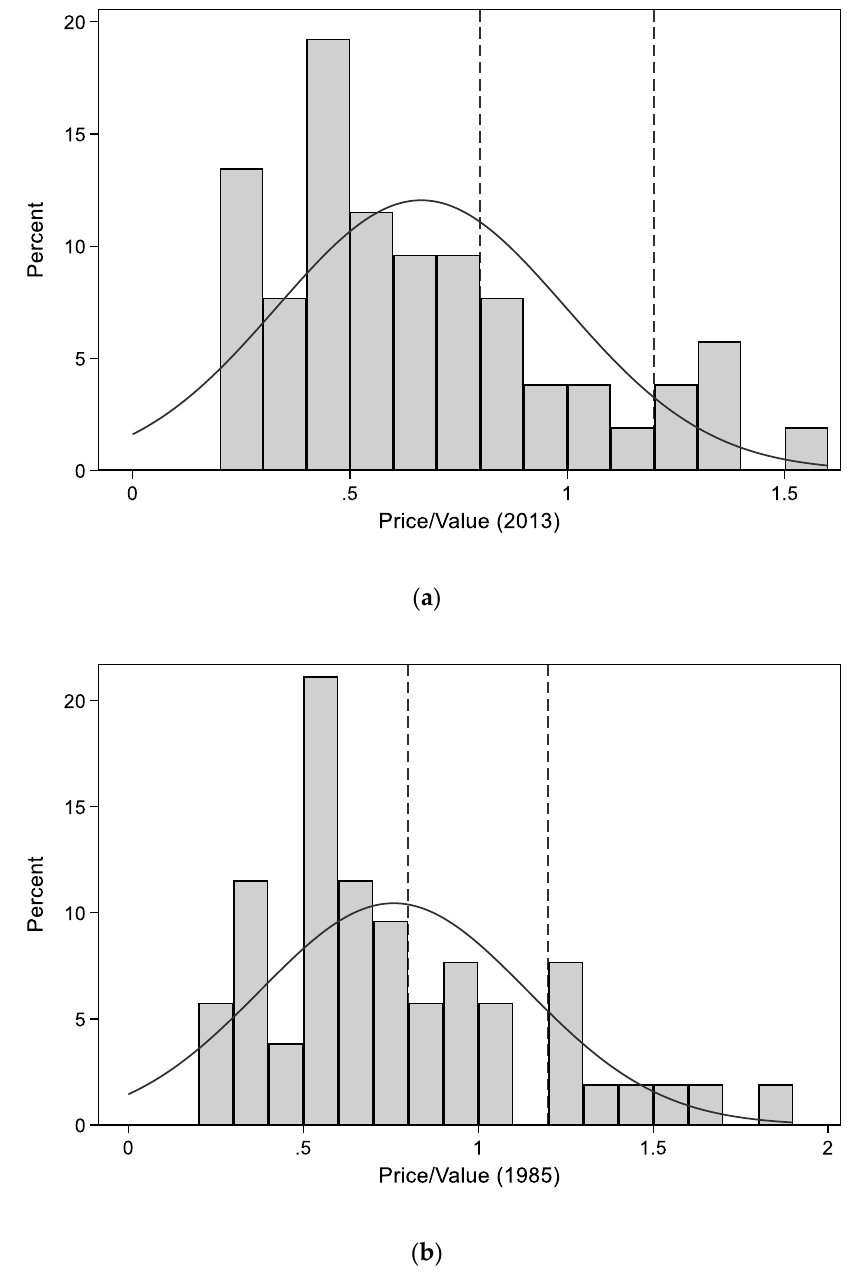
Figure 6. Distribution of price-to-value ratios by valuation methodology ( a ) upper panel ratios are based 2013 valuation tables; ( b ) lower panel ratios are based on 1985 valuation tables.